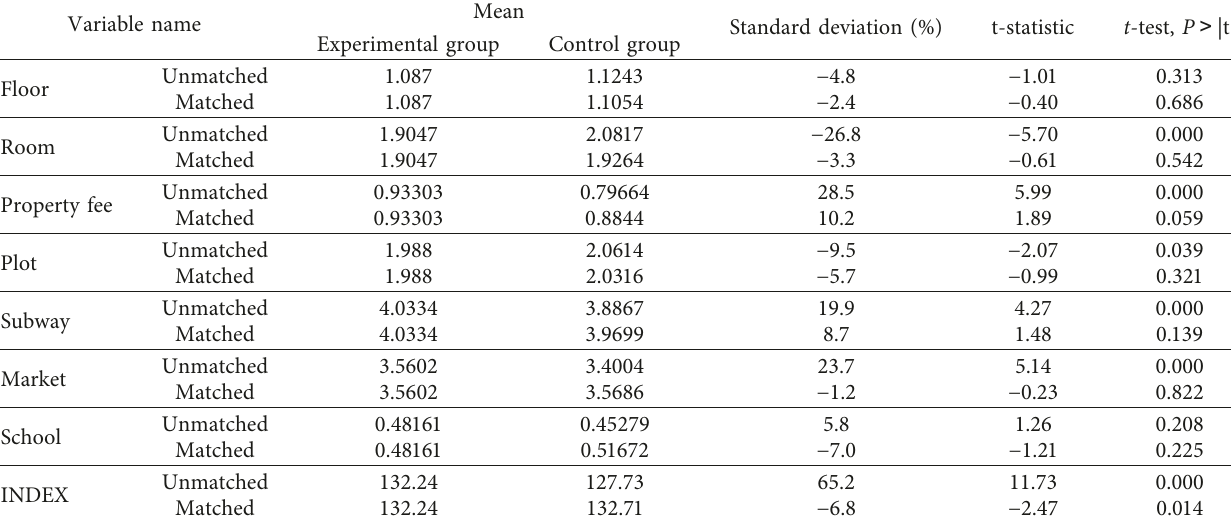
Table 8: PSM matching validity